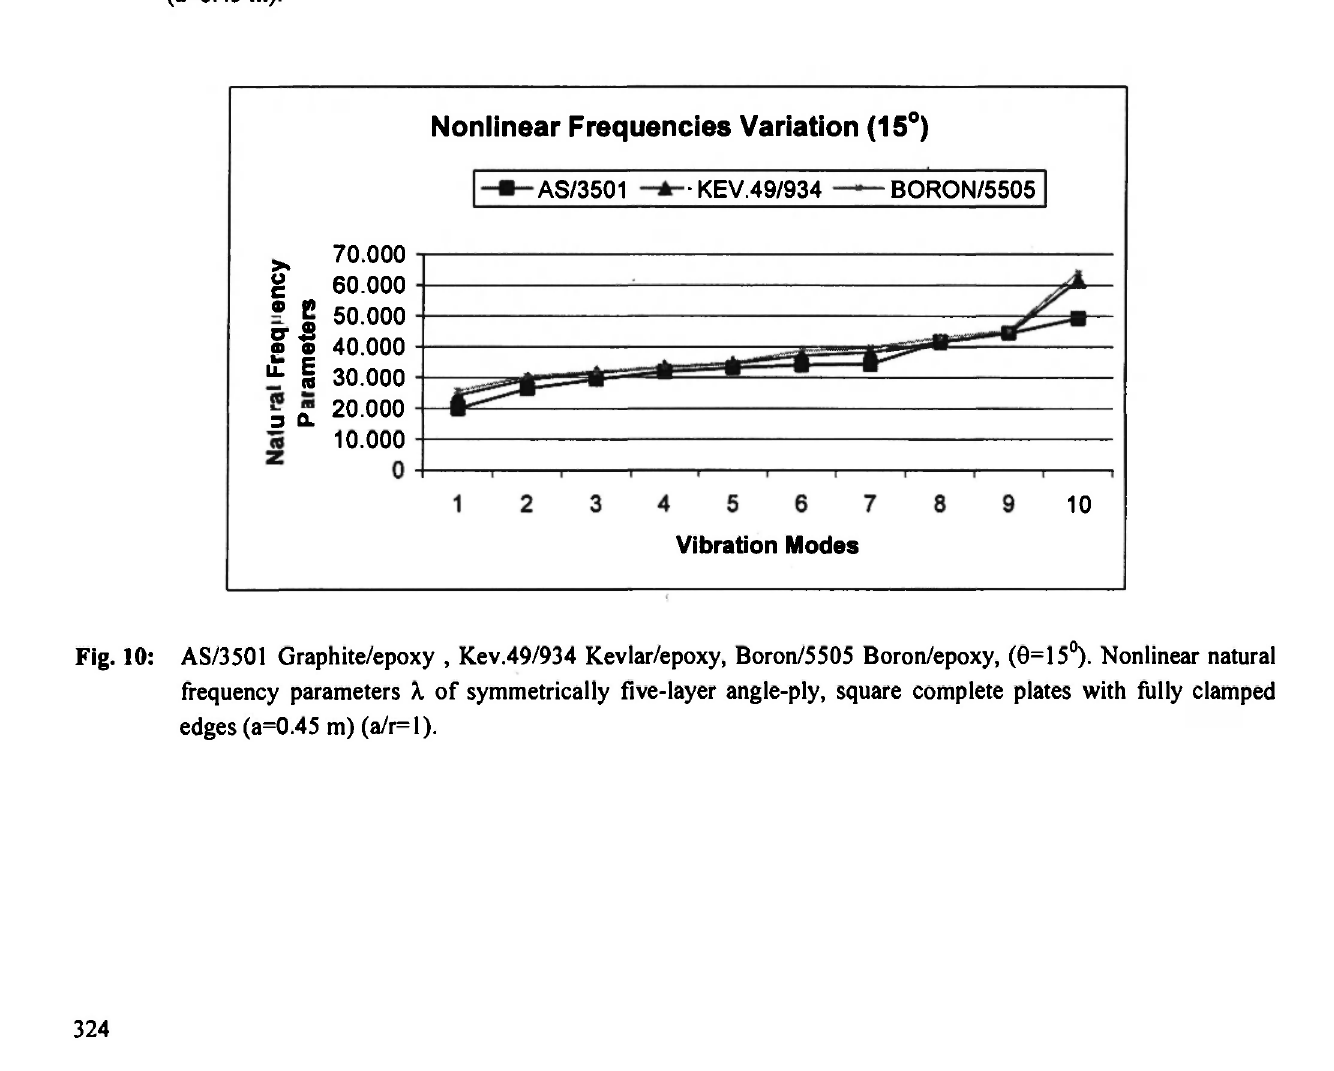
Fig. 9: AS/3501 Graphite/epoxy , Kev.49/934 Kevlar/epoxy, Boron/5505 Boron/epoxy, (θ= 15°). Linear natural frequency parameters λ of symmetrically five-layer angle-ply, square complete plates with fully clamped edges (a=0.45 m).